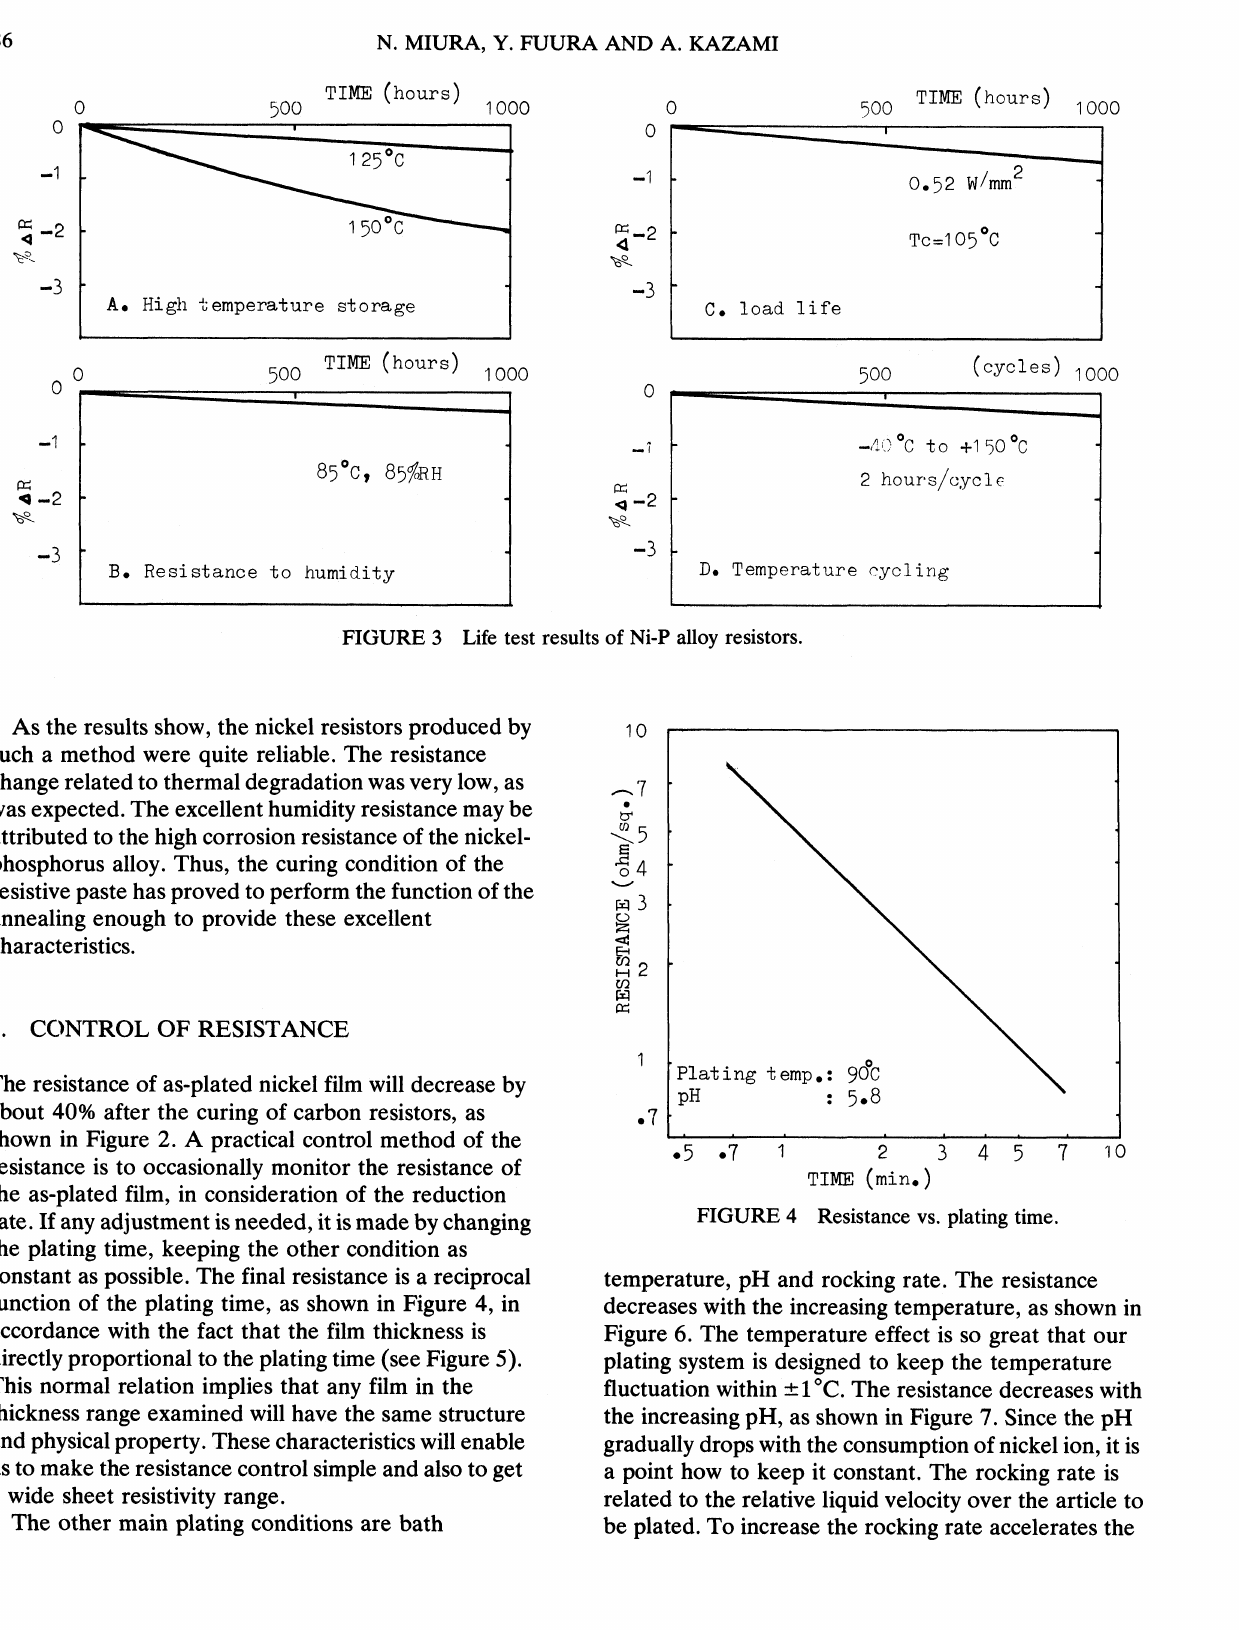
FIGURE 4 Resistance vs. plating